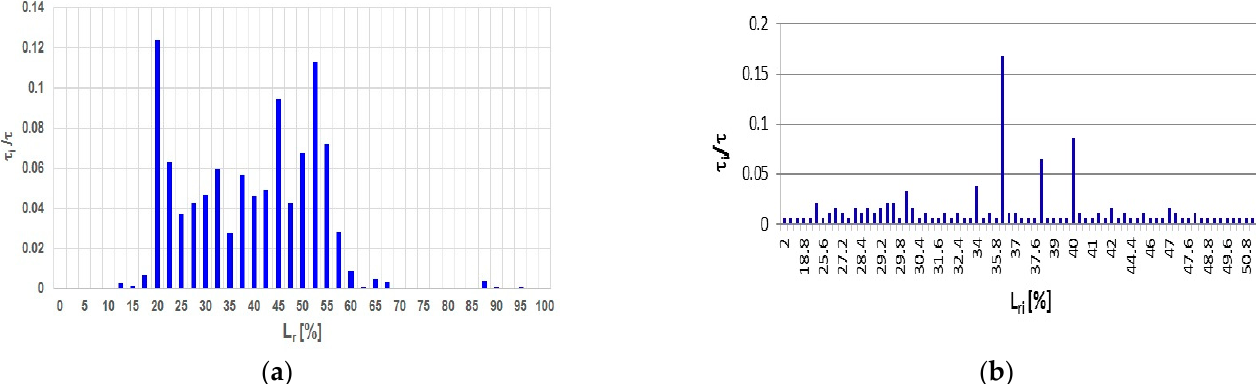
Figure 9. Histogram working times of generating sets at individual relative loads L r with the combustion engine from Wärtsilä ( a ) and MAN Energy Solutions company ( b ).